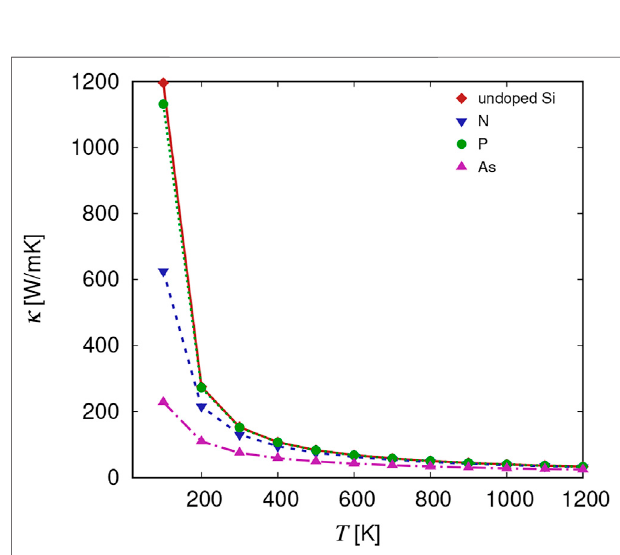
FIGURE 10 | Thermal conductivity in undoped Si (red diamonds) and doped with N (blue triangles), p (green circles), and As (pink triangles) at a concentration of 10 20 cm − 3 as a function of